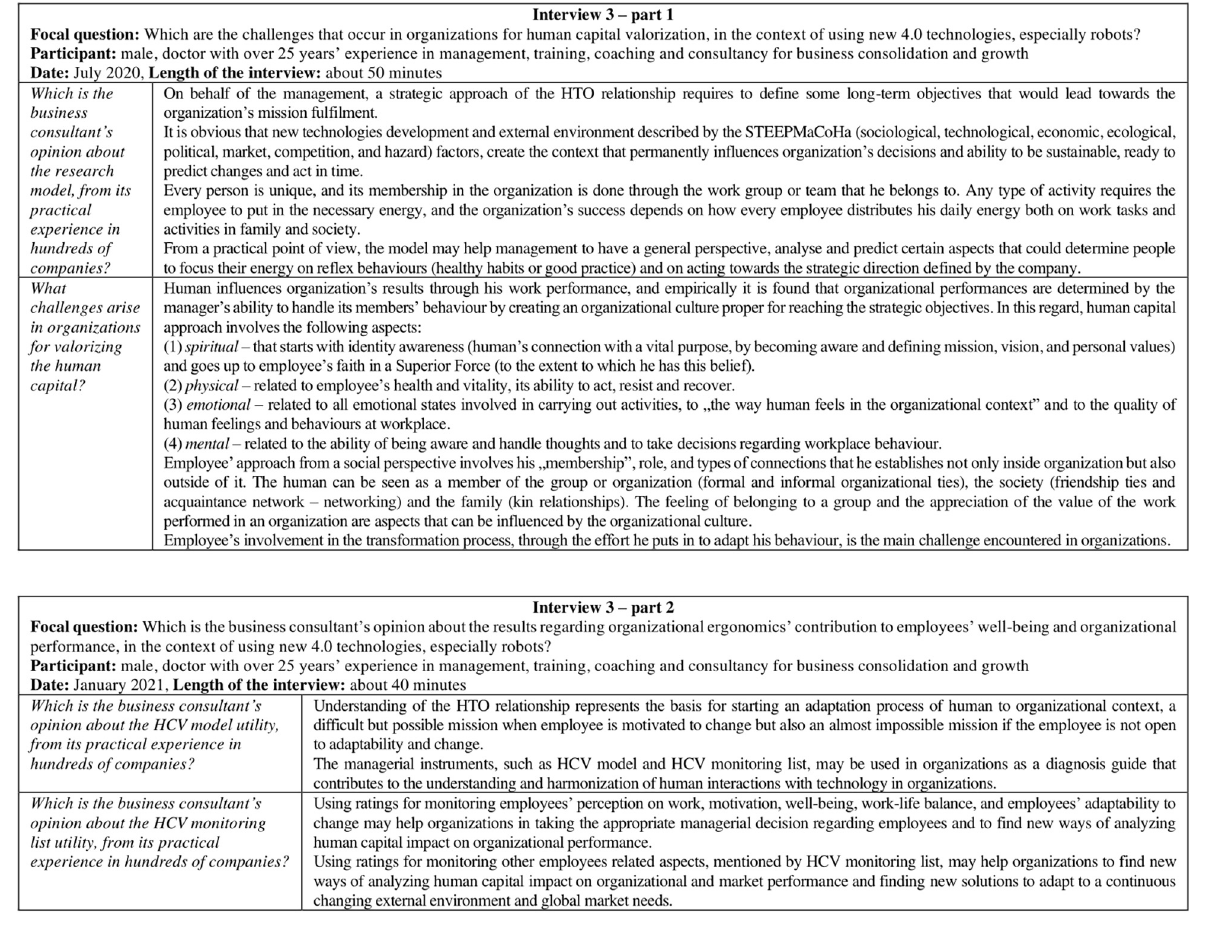
FIGURE 2 | Outputs of the second round of interviews.